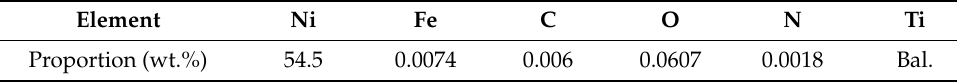
Table 2. Chemical composition of equiatomic NiTi50